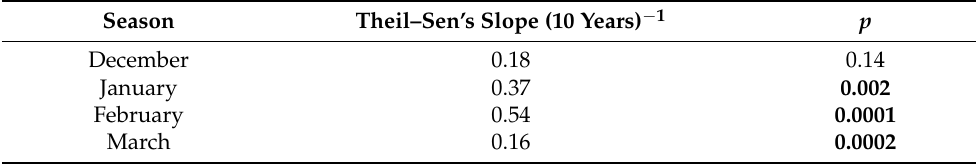
Table 3. Trends of air temperatures during the season of DJFM.